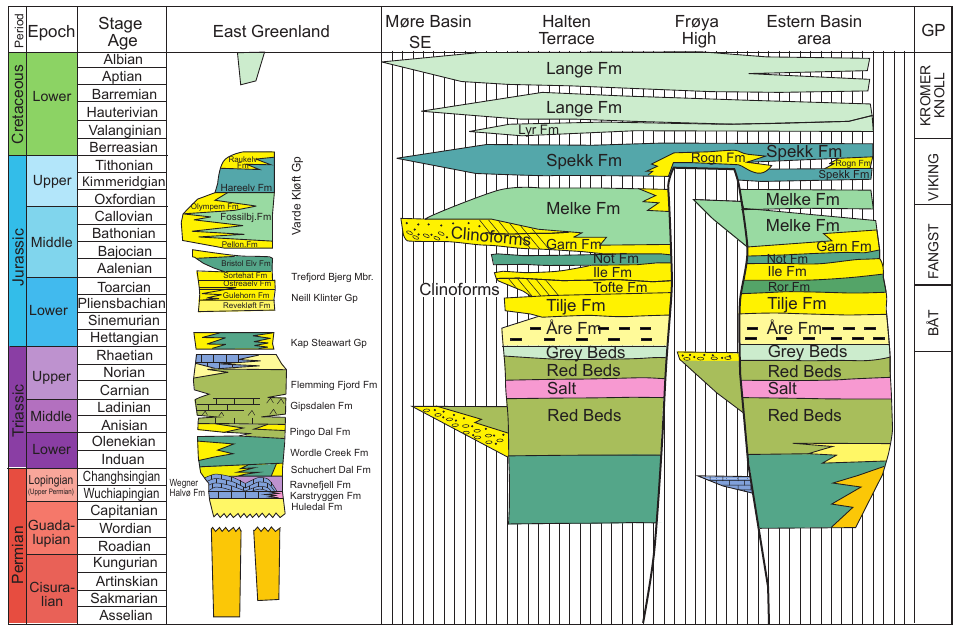
Figure 5. Lithostratigraphic compilation to illustrate pre-Upper Cretaceous basin infill-history onshore East Greenland and in the Norwegian Sea. Yellow colours show sand-dominated units. For further details, see text. Vertical lines show periods with non-deposition/stratigraphic breaks. The geological stratigraphic divisions are from Gradstein et al. (2004).